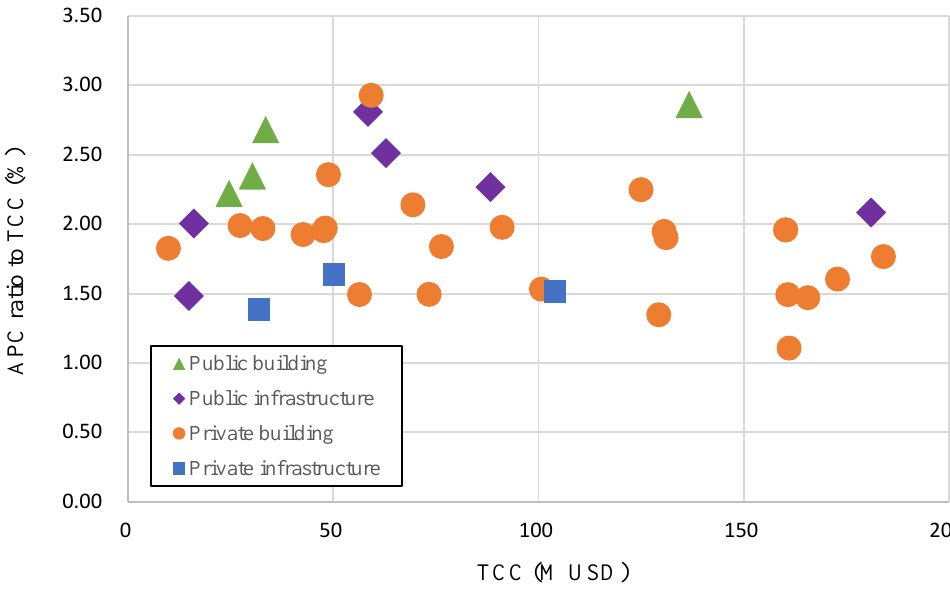
Figure 9. Plots of APC to TCC ratios for different facility types. Table 12. One-way analysis of variance (ANOVA) outcomes.